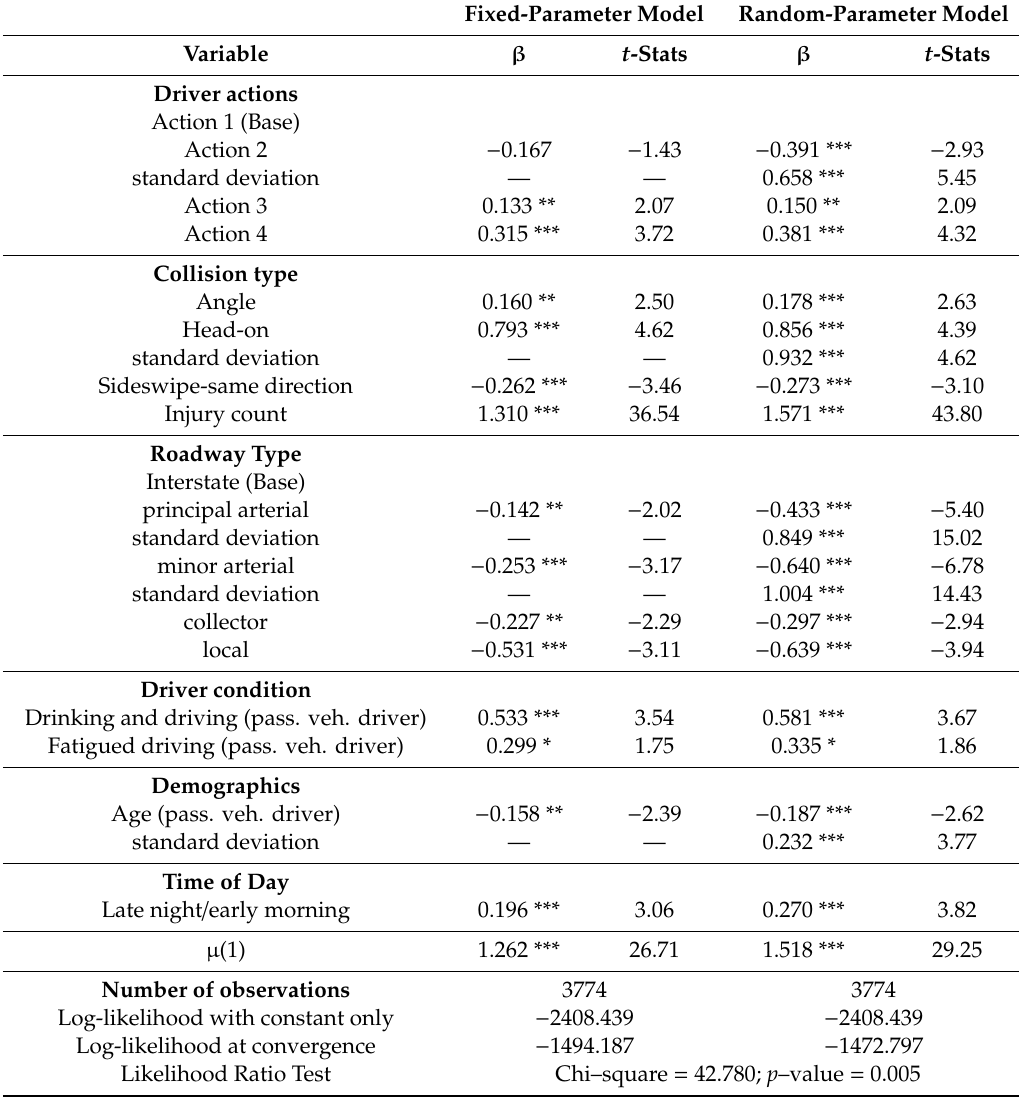
Table 3. Modeling results for fixed- and random-parameter ordered probit